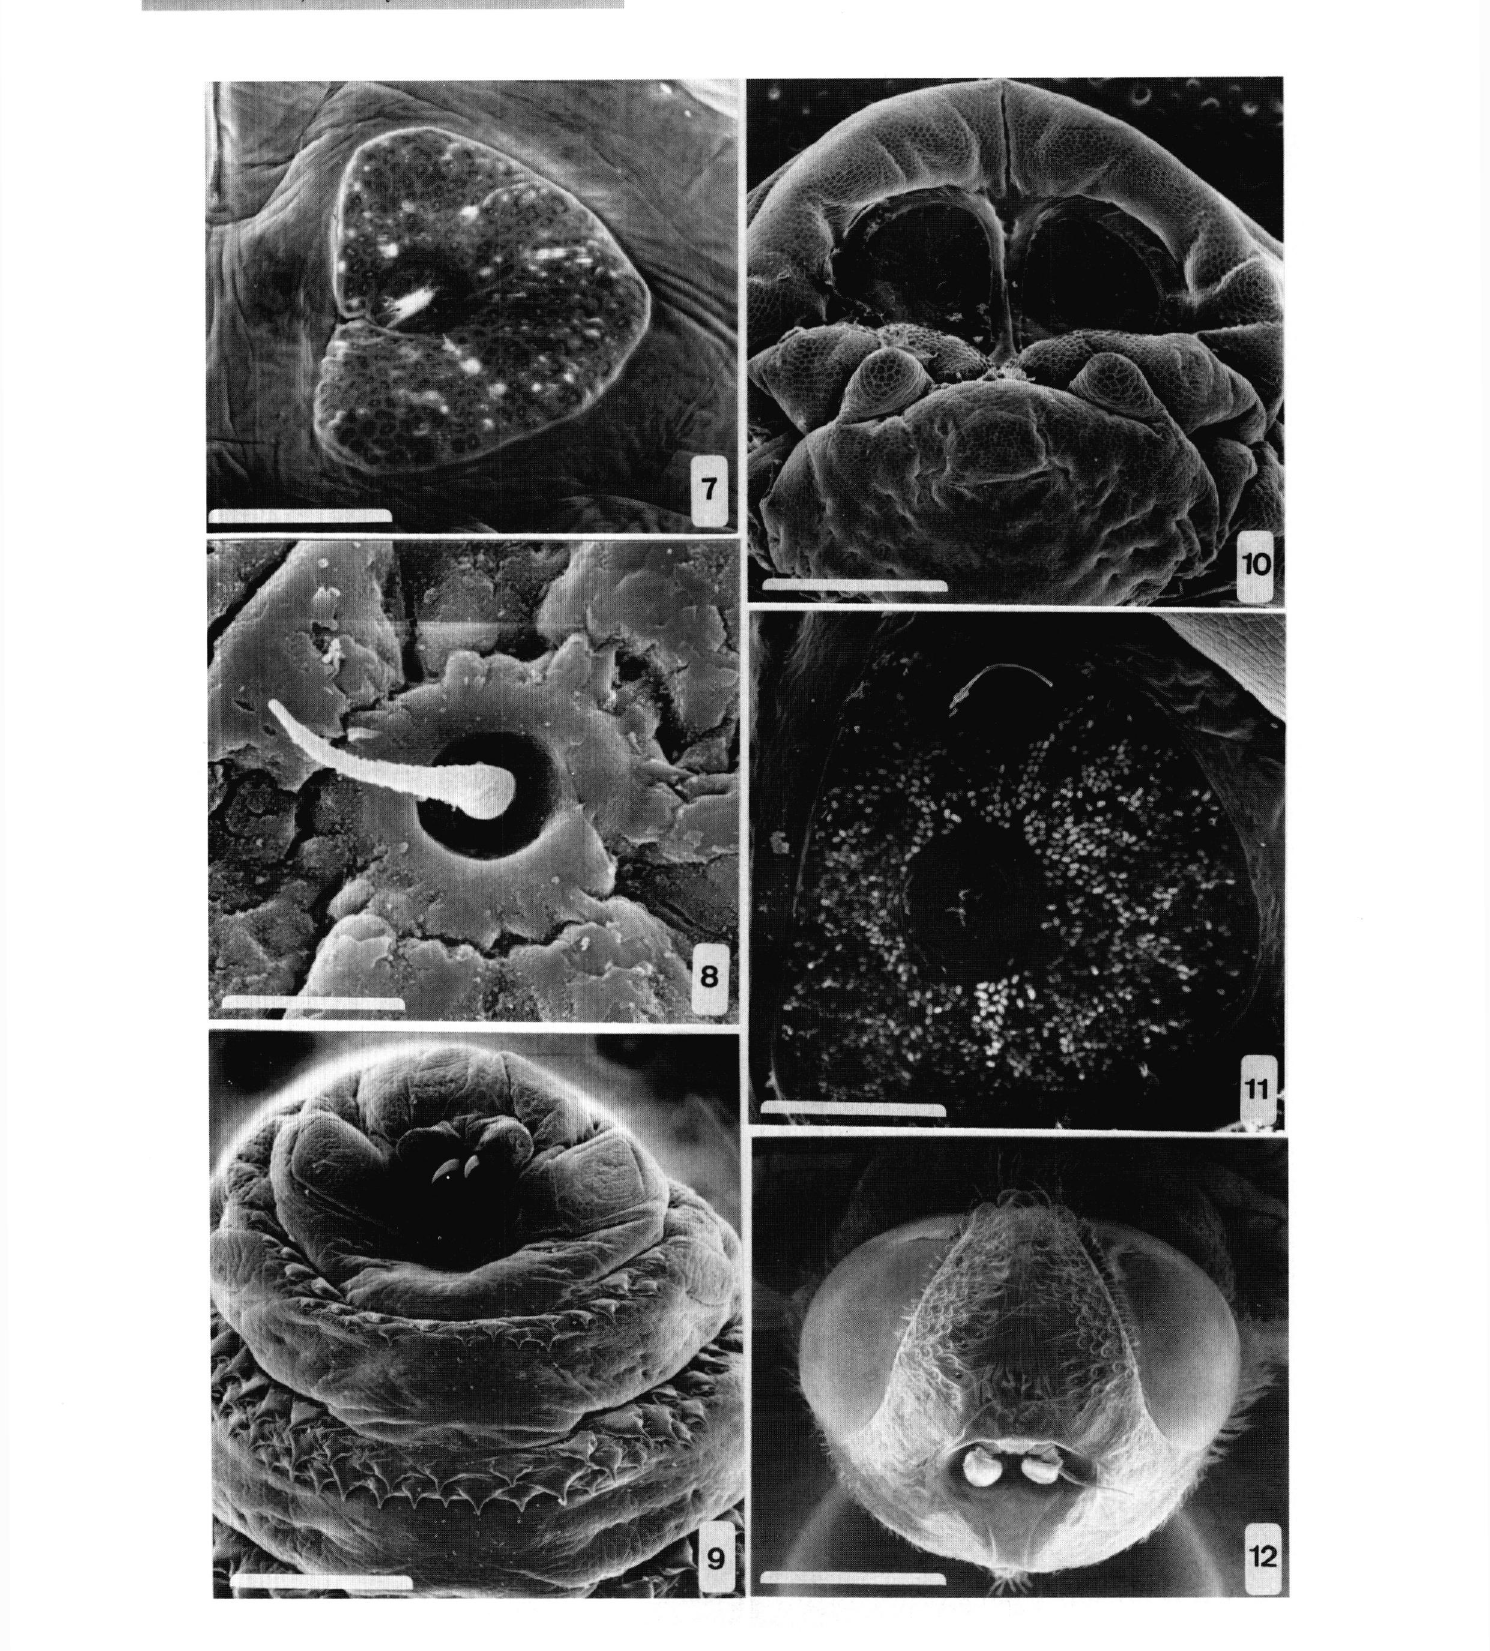
Fig. 7. - Posterior view of stigmatic plate of second larval instar. Bar =150 urn. Fig. 8. - Peri-stigmatic ciliated papillae of second larval instar. Bar = 8.6 um. Fig. 9. - Ventral view of anterior part of third larval instar. Bar = 1500 um. Fig. 10. - Posterior view of posterior end of third larval instar. Bar - 1500 urn. Fig. 11. - Posterior view of stigmatic plate of third larval instar. Bar = 500 urn. Fig. 12. - Frontal view of the head of the imago. Bar 1500 urn.